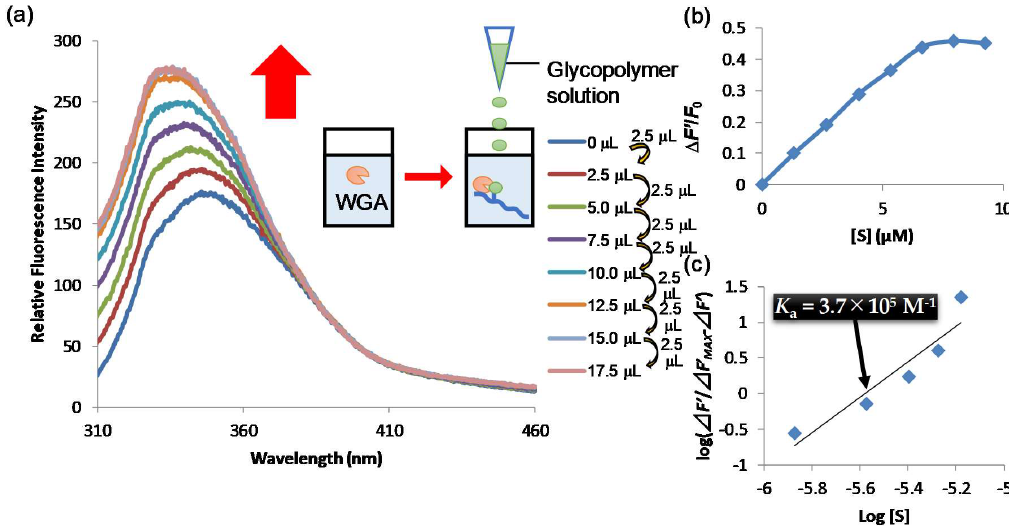
Figure 1. Biological evaluations of the WGA–carbohydrate interaction of 11b . ( a ) Changes in fluorescence emission spectra of WGA (0.65 µ M, 3.0 mL, 50 mM Tris-HCl buffer containing 150 mM NaCl, pH 7.4, 4 ◦ C) upon addition of 2.5- µ L aliquots of glycopolymer 11b (74.5 µ M). ( b ) Plots of ∆ F’ / F 0 versus [S], where ∆ F’ is the change in the intensity at 348 nm of WGA with various concentrations of 11b , F 0 is the intensity of WGA alone, and [S] is total ligand concentration. ( c ) Hill plots of log [∆ F ′ /( ∆ F ′ MAX − ∆ F ′)] versus log [S]. Table 3. Results of the binding assays for WGA on the basis of fluorescence measurements.